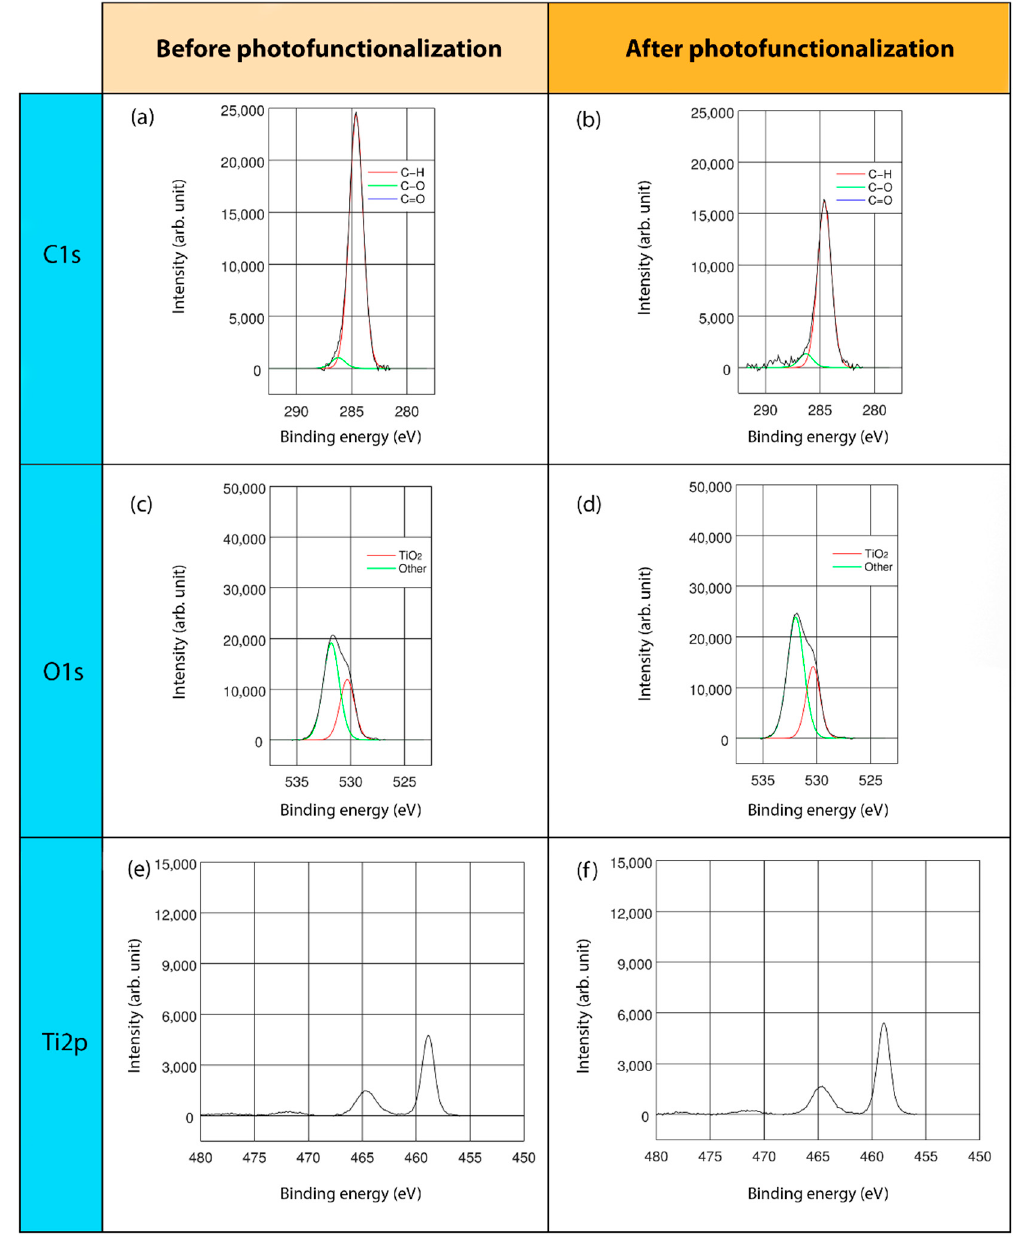
Figure 3. XPS analyses of TiUnite surface: XPS full-range spectra and deconvoluted XPS, with lines analysis and binding energies of C1s, O1s and Ti2p; before ( a , c , e ) and after ( b , d , f ) LED-based UVC photofunctionalization.